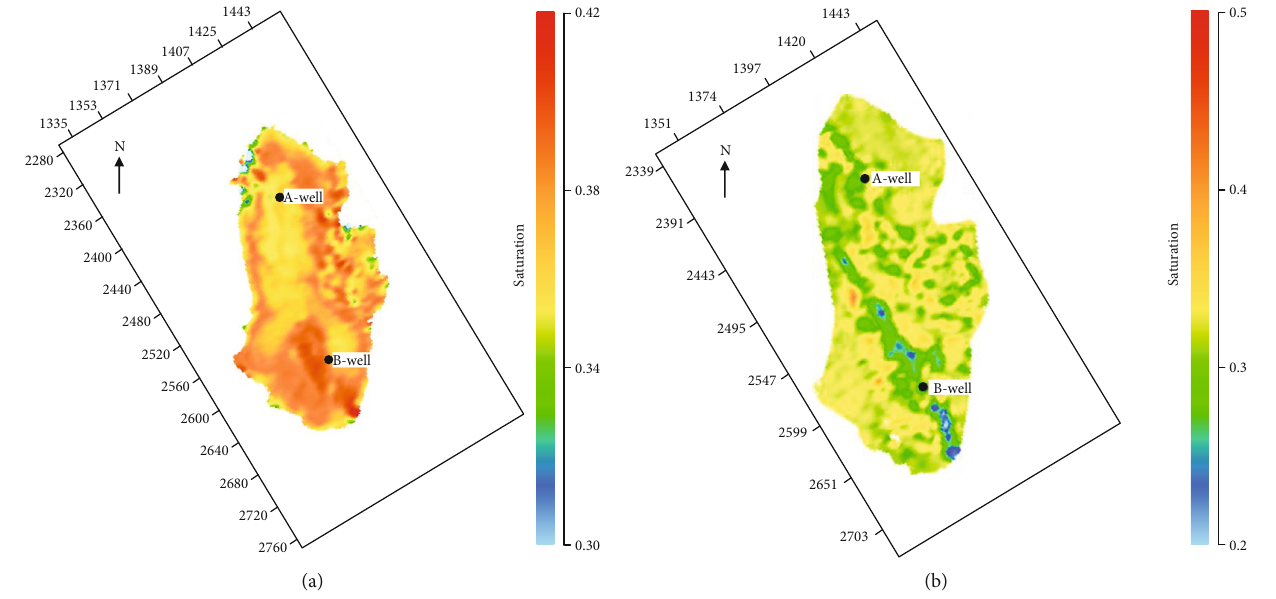
Figure 17: Plane distribution of average saturation for gas hydrate and free gas in the A-B ore body.